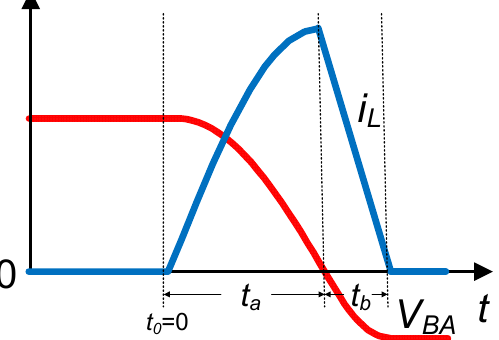
Figure 5. Waveform of the voltage V BA and inductor current i L.